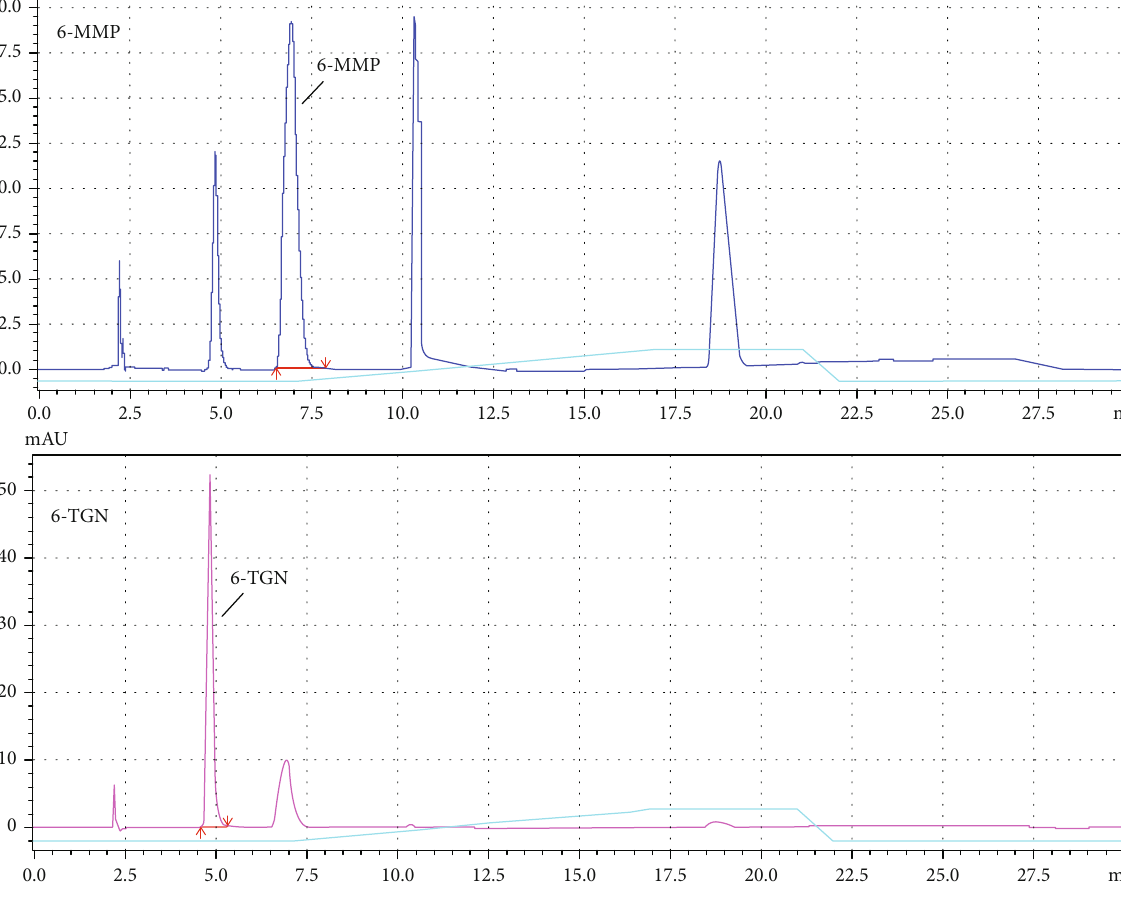
Figure 2: Representative examples of full HPLC spectra acquired for the measurements of thiopurine metabolites, 6-MMP (top) and 6-TGN (bottom). The marked peaks are speci fi c for 6-MMP and 6-TGN, respectively. The remaining peaks do not have an in fl uence on result